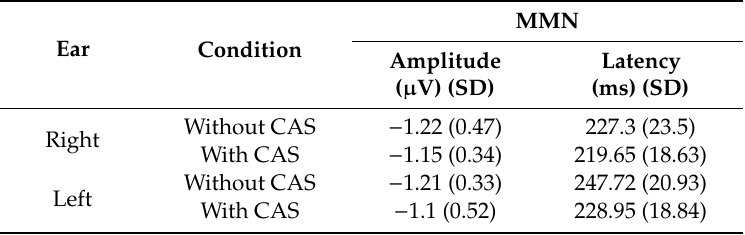
Figure 2. Grand average waveforms for event-related potential (ERP) responses to standard and deviant stimuli in the passive (MMN) condition, and the difference between the two (deviant–standard). Waveforms were averaged across frontal, mid-frontal, central and mid-central sites. Panel ( A ): left ear, no contralateral acoustic stimulation (CAS). Panel ( B ): left ear, with CAS. Panel ( C ): right ear, no CAS. Panel ( D ): right ear, with CAS. Table 3. Descriptive statistics of peak amplitudes and peak latencies of mismatch negativity (MMN) in the two conditions in the two ears. Please see text for sites grouped for analysis. CAS = Contralateral Acoustic Stimulation, µ V = micro Volts, ms = milliseconds, SD = Standard Deviation.